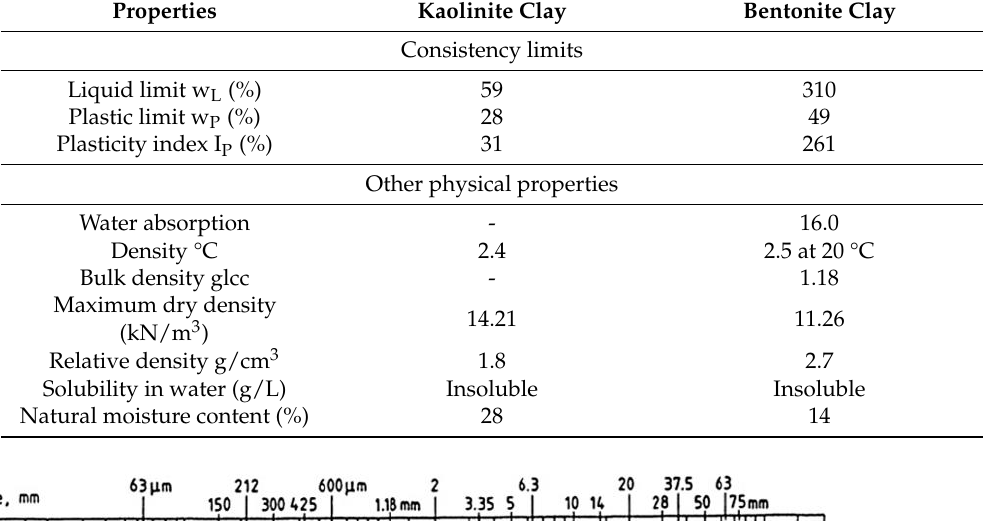
Table 4. Consistency limits and physical properties of kaolinite and Bentonite.